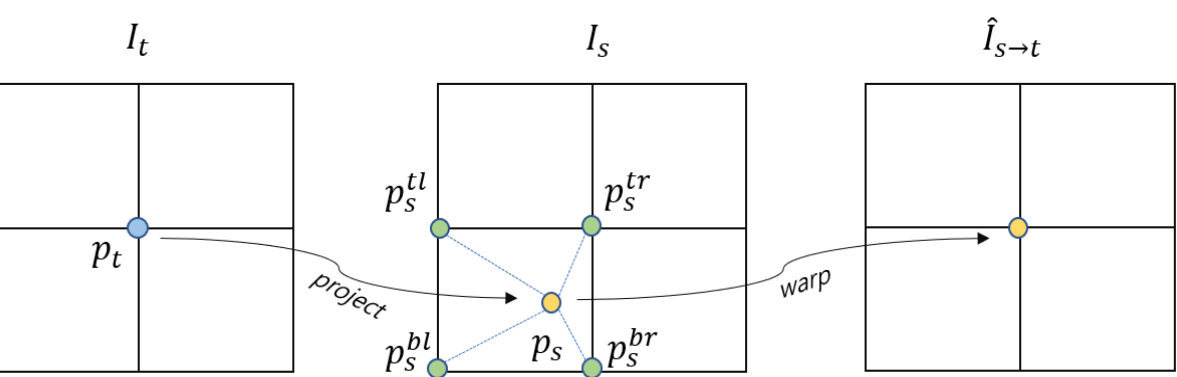
(cid:1835)(cid:4632) (cid:1868) (cid:3047) of (cid:3046)→(cid:3047) . As